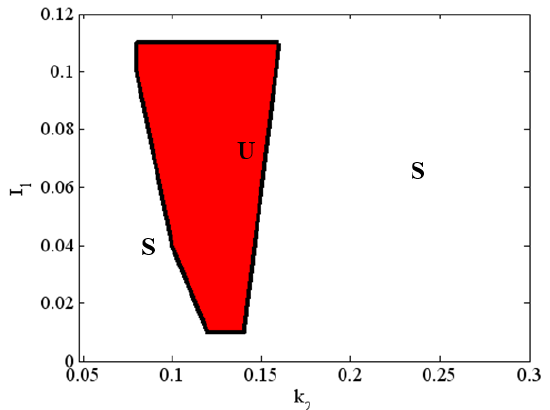
() , k I space. Legend: U — unstable zone; Figure 4. Bifurcation diagram of system (1) in the Figure 4. Bifurcation diagram of system (1) in the ( I 1 , k 2 ) space. Legend: U —unstable zone; S — 2 1 S — stable zone; solid line — boundary of stability for Andronov – Hopf bifurcation. For clarity, the stable zone; solid line —boundary of stability for Andronov–Hopf bifurcation. For clarity, the stable  95 . 0 , 3 . 0  k is not shown. All other parameter values are as those in (5), and stable zone when zone when k 2 ∈ [ 0.3, 0.95 ] is not shown. All other parameter values are as those in (5), and 2 c on s t I I = = + . 12 . 0 I 1 + I 2 = 0.12 = const . 2 1